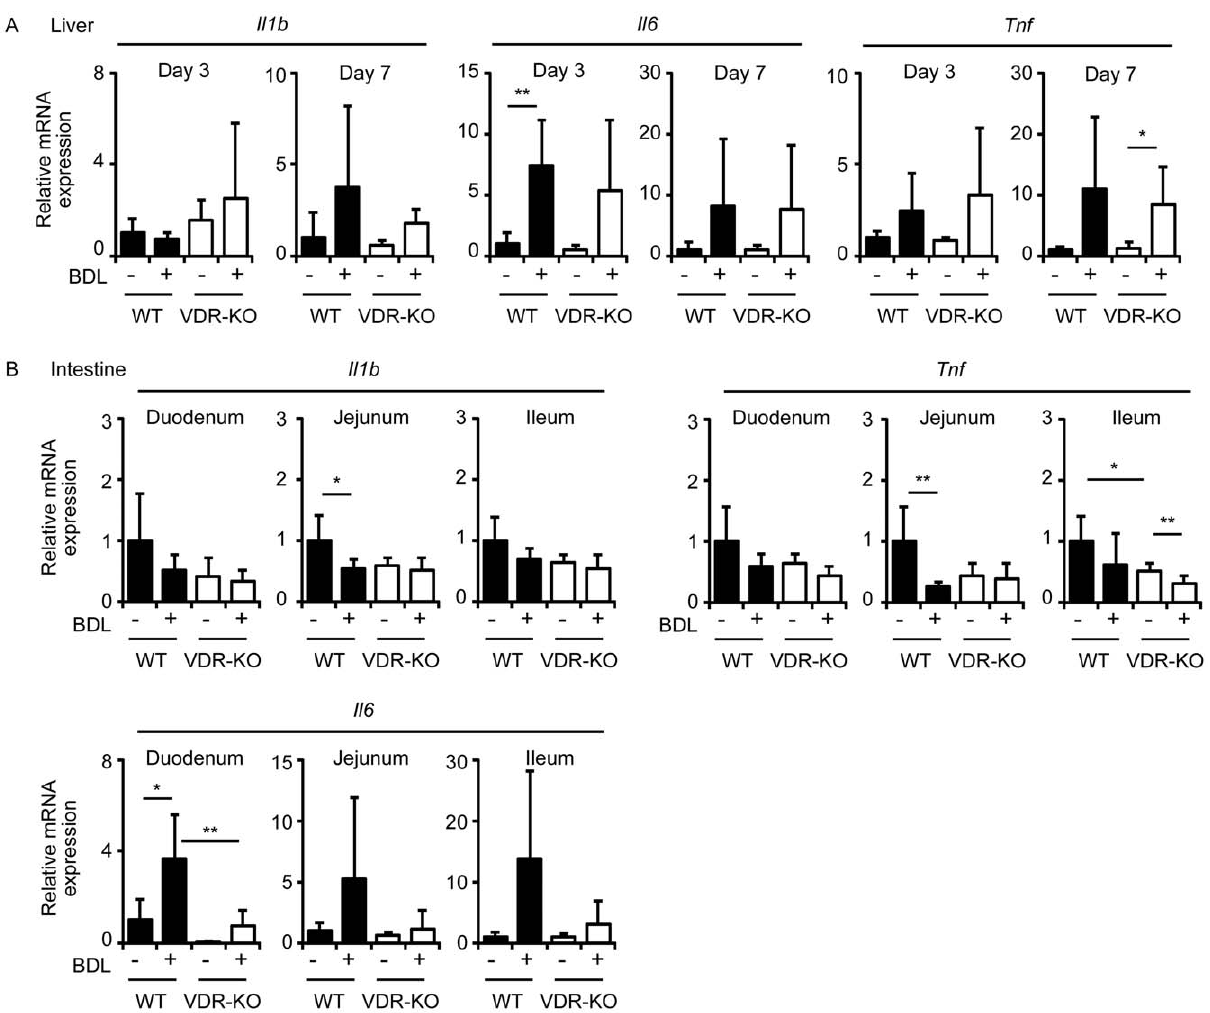
Figure 4. mRNA expression of inflammatory cytokines in the liver (A) and intestine (B). Total RNAs were prepared from the liver of wild- type mice (WT) and VDR-null mice (VDR-KO) 3 days and 7 days after sham operation or BDL. The values represent means 6 S.D. * p , 0.05; ** p ,